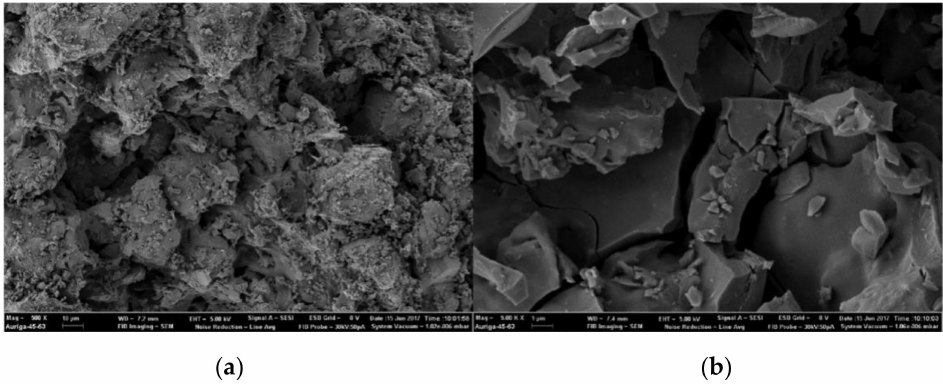
Figure 2. SEM image of recycled brick aggregate [59]: ( a ) 500 × ; ( b ) 1000 ×